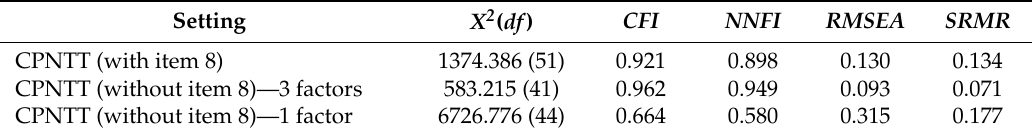
Table 2. Indices of model fit for the CPNTT with di ff erent settings to evaluate item 8.